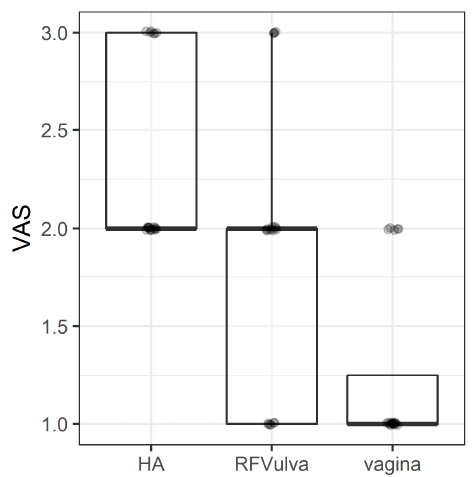
Figure 5. The visual analog scale (VAS) to evaluate analgesic effects of various therapies. The middle line of the boxplot is median, the lower and upper hinges correspond to the first and third quartiles (the 25th and 75th percentiles). The upper whisker extends from the hinge to the largest value (no further than 1.5*IQR from the hinge, IQR is the interquartile range—distance between the first and third quartiles). The lower whisker extends from the hinge to the smallest value (no further than 1.5*IQR of the hinge). Median line overlaps with lower and upper hinges.